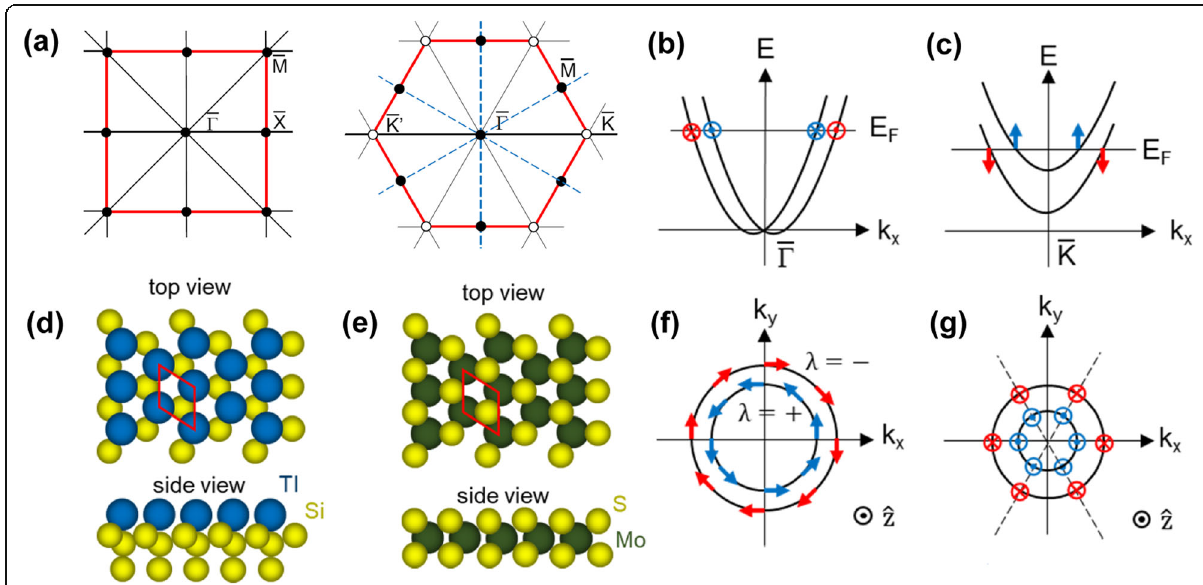
Fig. 1 Schematic drawings of 2D crystal structures and Rashba/Zeeman-type SOC. a 2D Brillouin zones of square (left) and triangular (right) lattices. The red lines represent the 2D Brillouin zone boundaries. The solid circles ( Γ , X, M) and open circles (K ; K 0 ) represent TRIM points and non- TRIM points, respectively. b , c Spin-split energy bands and spin structures due to b Rashba-type SOC and c Zeeman-type SOC. d , e Atomic structure models of d Si(111)-(1 × 1)-Tl [56] and e MoS 2 monolayer [60, 61]. The red parallelograms show the unit cells. f , g Spin-split Fermi surfaces and spin structures at E = E F due to f Rashba-type SOC and g Zeeman-type